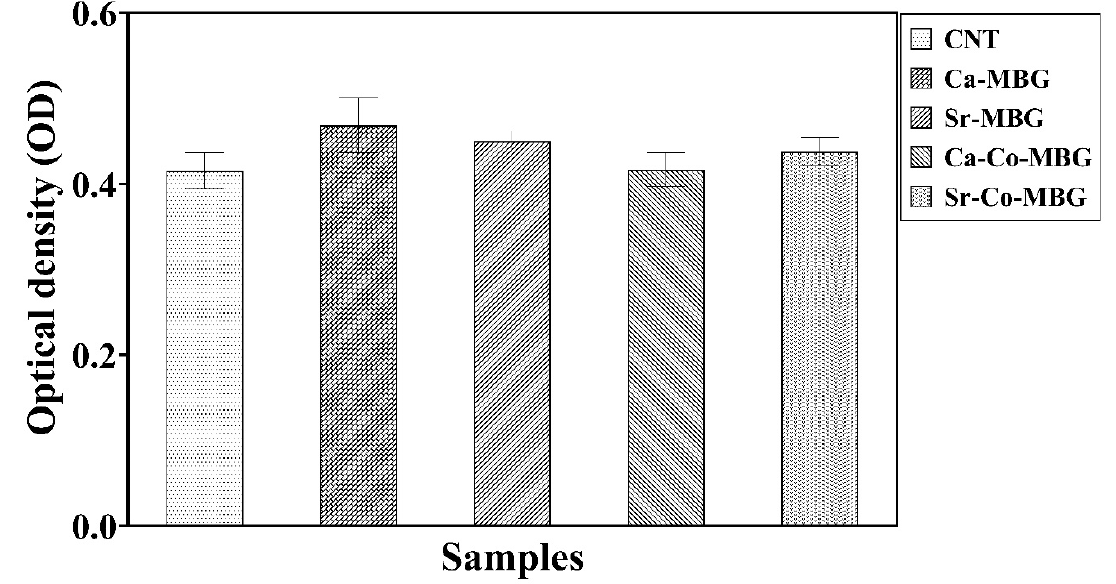
Figure 9. Cell viability: results of MTT assay at 24 h post-incubation.